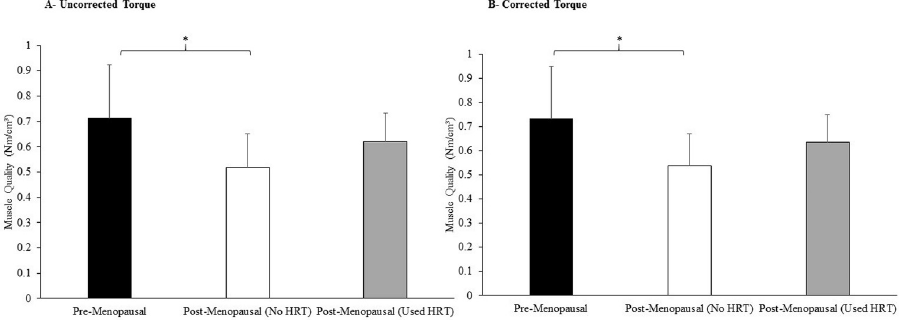
Fig 2. Comparison of participants’ muscle quality (utilizing uncorrected maximum torque (A) and maximum torque corrected for co-contraction (B) categorized by participants’ menopause phase and use of hormone replacement therapy. Values are means ± SDs. Different from Pre-Menopausal and Post-Menopausal, � P < 0.05.